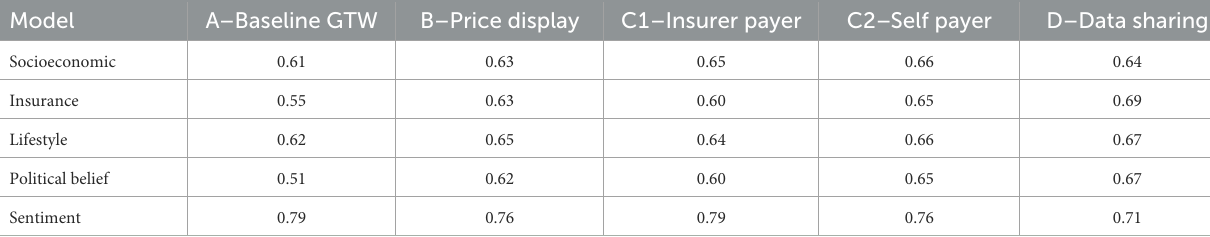
TABLE 11 Prediction accuracy per regression